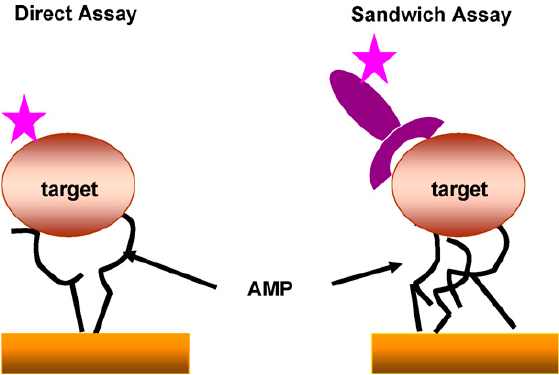
Figure 2. Schematic principle of the assays developed by Kulagina et al. in which the